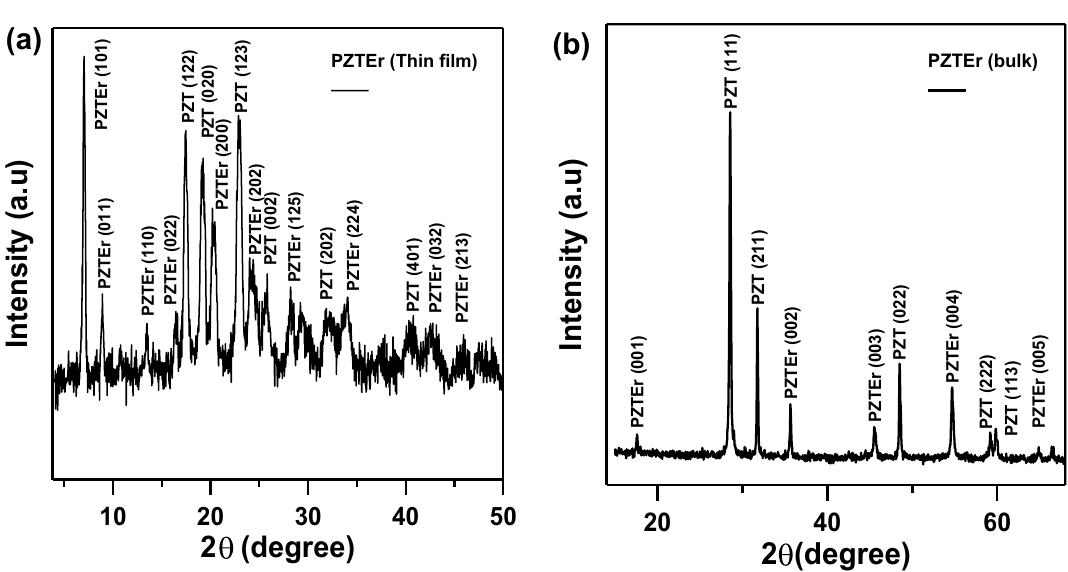
Figure 3. ( a ) XRD pattern of Er-doped PEZT thin film sample. ( b ) XRD pattern of Er-doped PEZT bulk